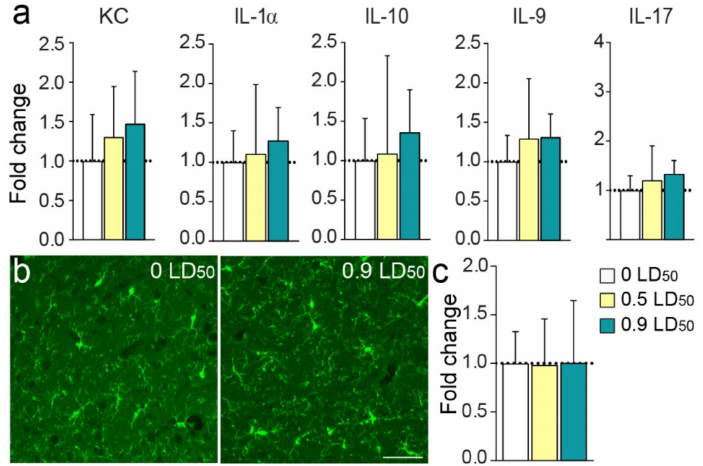
Figure 4. NIMP exposure does not induce long-term neuroinflammation in the amygdala/piriform cortex. ( a ) Expression levels of the cytokines KC, IL-1 α , IL-10, IL-9 and IL-17 normalized to CTL values at 6 months post-intoxication [(KC: 1.0 ± 0.2 for 0 LD50; 1.3 ± 0.2 for 0.5 LD50 and 1.5 ± 0.2 for 0.9 LD50); (IL-1 α : 1.0 ± 0.2 for 0 LD50; 1.1 ± 0.3 for 0.5 LD50 and 1.3 ± 0.2 for 0.9 LD50); (IL-10: 1.0 ± 0.2 for 0 LD50; 1.1 ± 0.5 for 0.5 LD50 and 1.4 ± 0.2 for 0.9 LD50); (IL-9: 1.0 ± 0.1 for 0 LD50; 1.3 ± 0.3 for 0.5 LD50 and 1.3 ± 0.1 for 0.9 LD50) and (IL-17: 1.0 ± 0.1 for 0 LD50; 1.2 ± 0.3 for 0.5 LD50 and 1.3 ± 0.1 for 0.9 LD50)]. Statistical analyses were conducted by one-way ANOVA ( n = 8 per group). ( b ) IBA-1 labeling in the amygdala region of CTL ( left ) and 0.9 LD50 ( right ) mice. Scale bar = 50 µ m. ( c ) Fold change of IBA1 labeling the optical density percentage normalized to CTL at 6 months post-intoxication: 1.0 ± 0.1 for 0 LD50; 0.98 ± 0.2 for 0.5 LD50 and 1.0 ± 0.2 for 0.9 LD50. Statistical analyses were conducted by Kruskal–Wallis test ( p = 0.83; n = 7 per